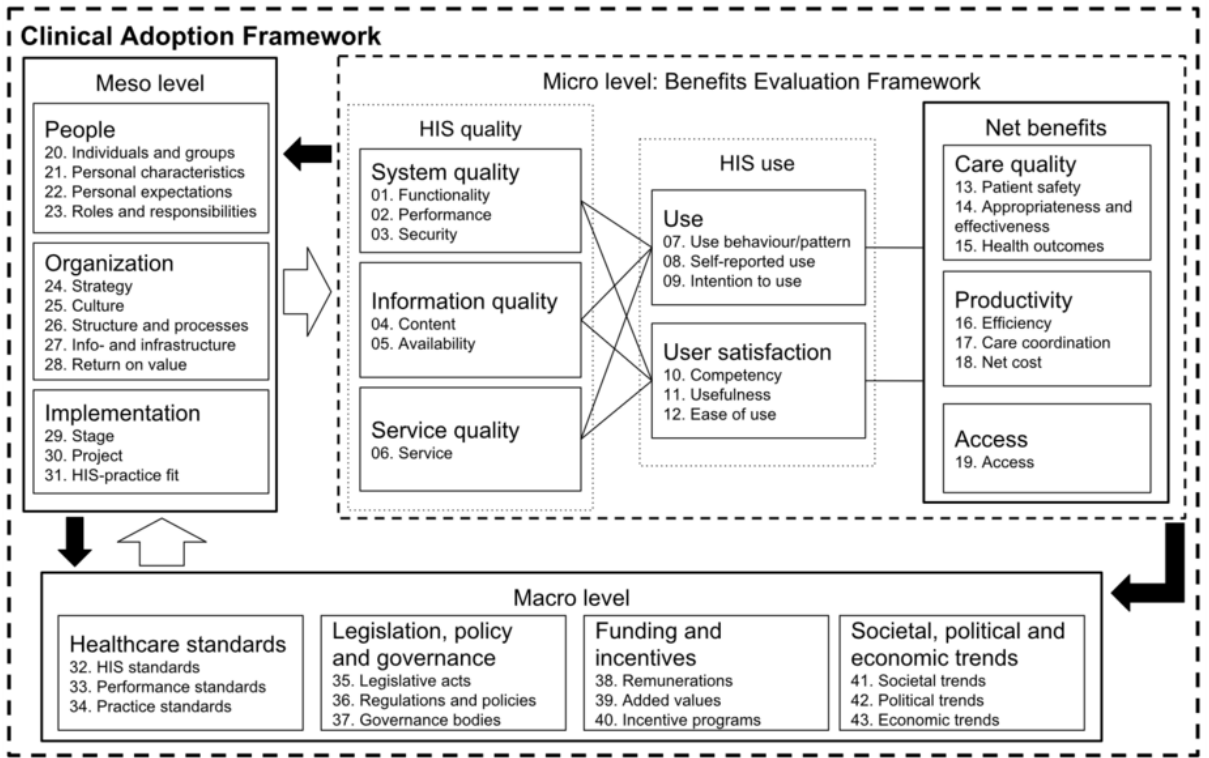
Figure 1. Clinical Adoption Framework with levels, dimensions, and categories. HIS: health information system. Originally published in [10,